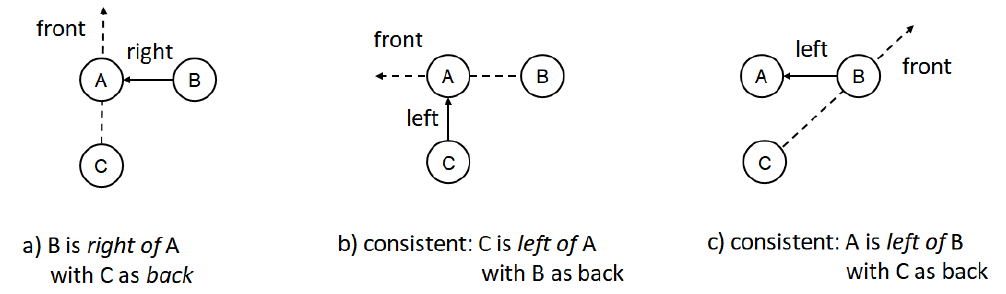
Figure 12. Consistency reasoning through reference direction translation. ( a ) an existing relationship; ( b ) another new relationship that is consistent with the existing one, determined by reference direction translation; ( c ) another relationship that is inconsistent with the previous